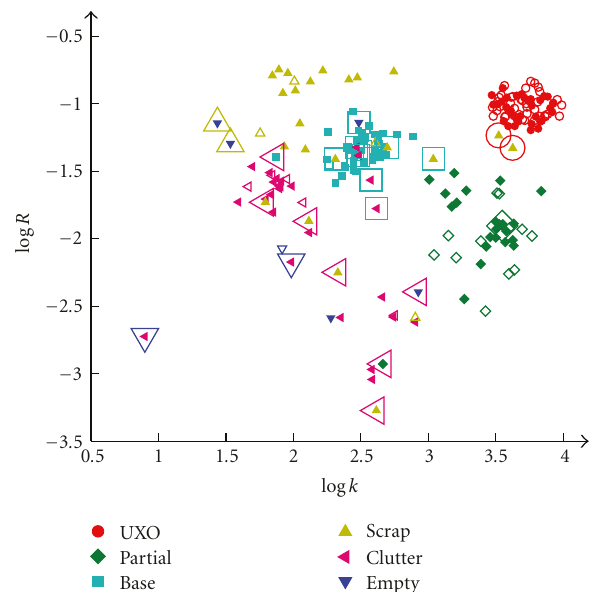
Figure 6: Result of the SVM classification for the Camp Sibert anomalies using the logarithms of k and R ≡ Q ( t 15 ) /Q ( t 1 ). The SVM has been trained with capacity C = 10 and kernel width σ = 1 / 200. The small markers denote the ground truth for both training (hollow) and testing (solid) cells. The larger markers highlight the cases where there is a disagreement between the ground truth and the SVM